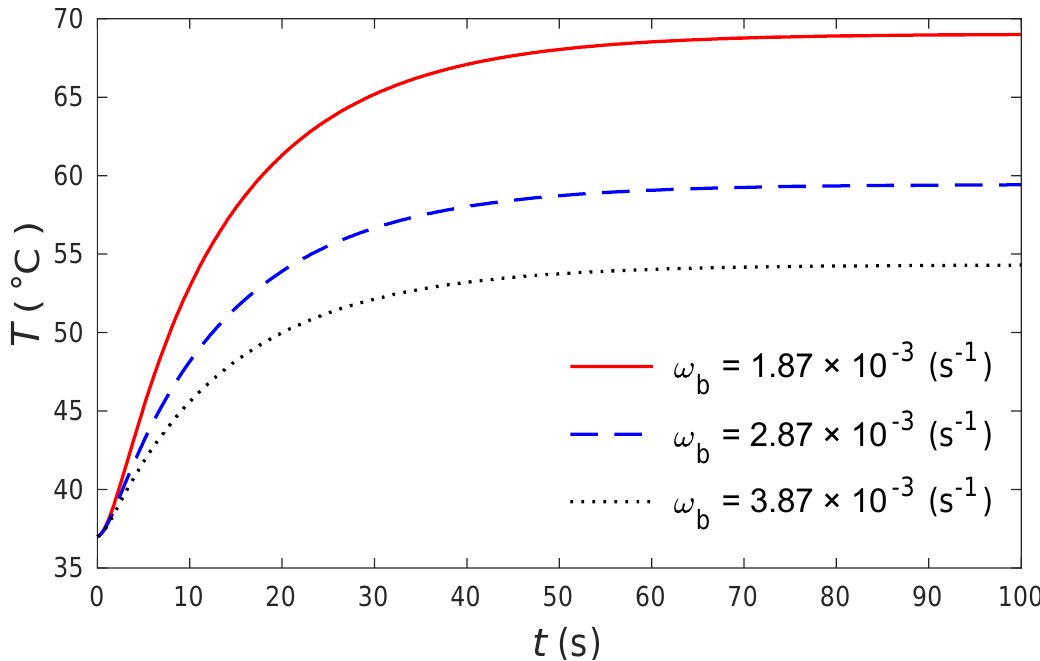
Figure 6. The skin surface temperature over time for different values of 𝜔 𝑏 .